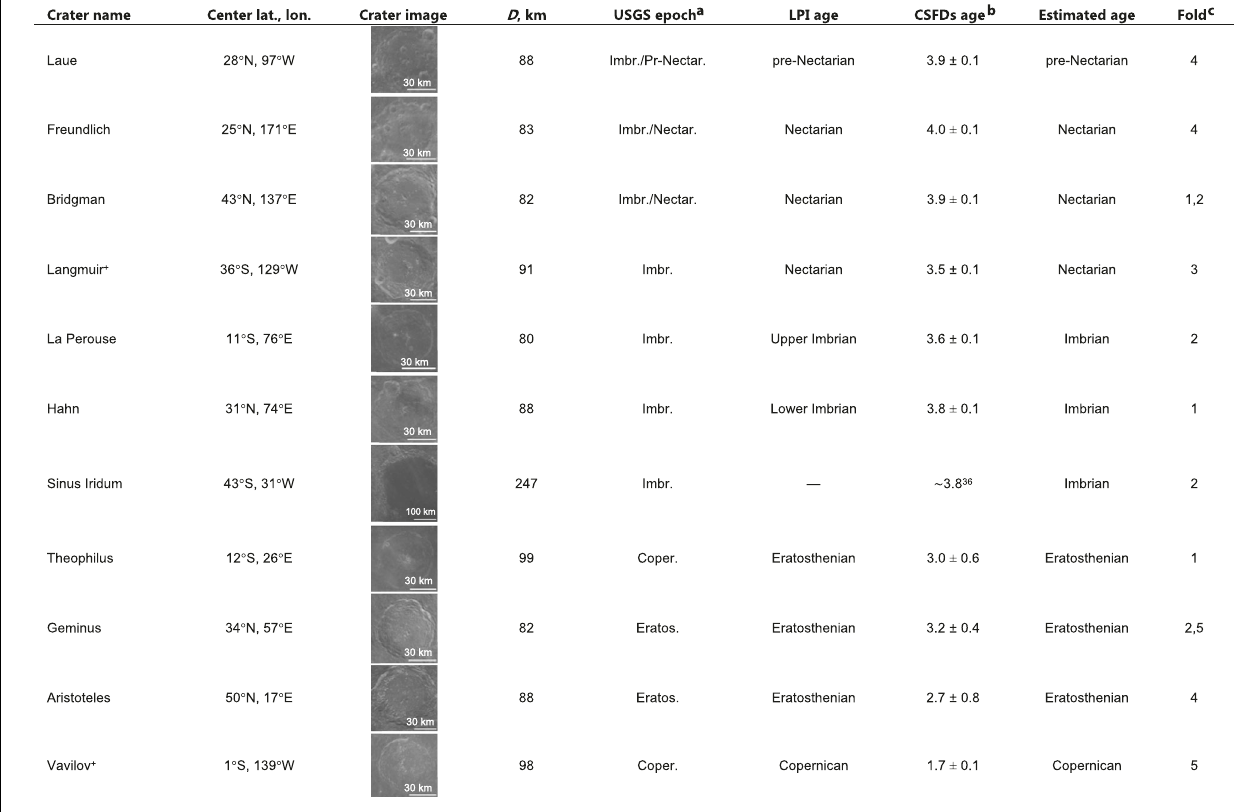
Table 4 Comparison with the crater age by the crater size – frequency distributions